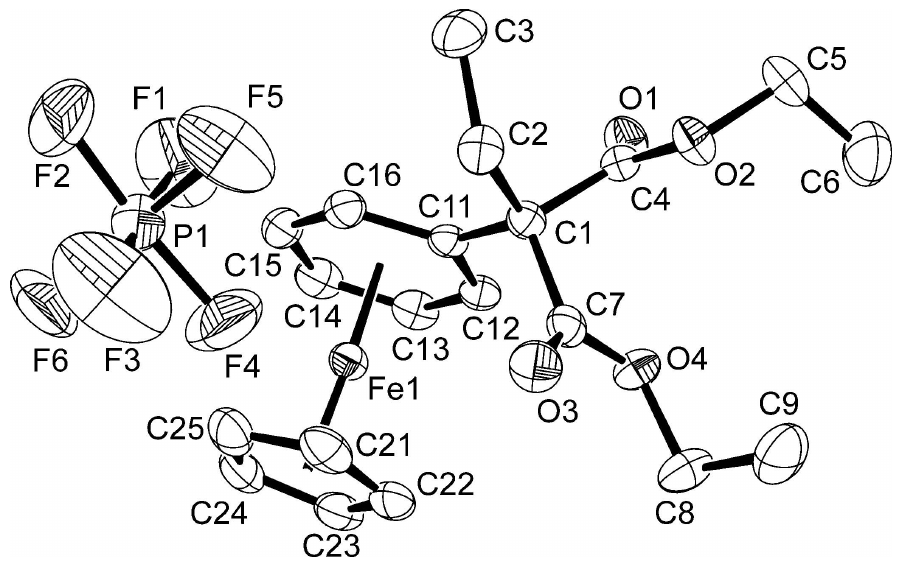
Figure 1 View of the cation and anion showing the labelling of non-H atoms with the thermal ellipsoids shown at 50% probability levels.